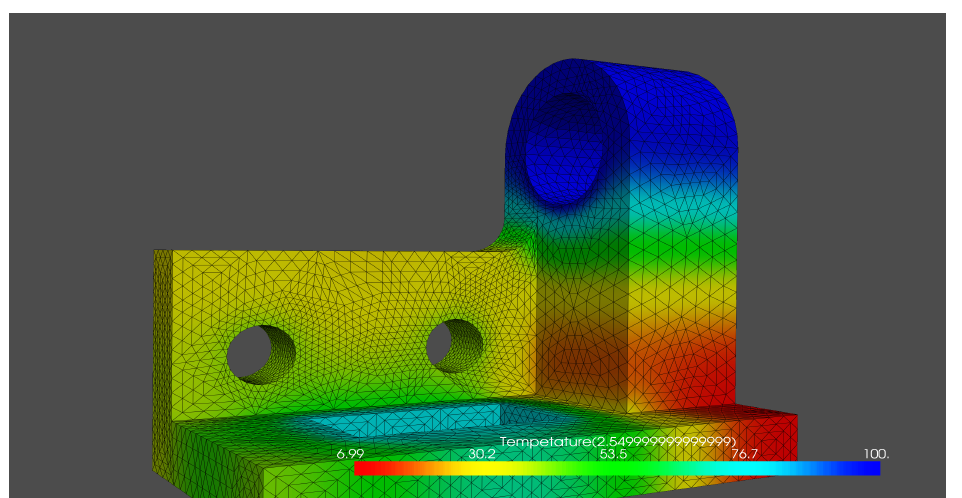
Figure 11. Temperature contour of a function space of order 1 at t = 2.55 s.